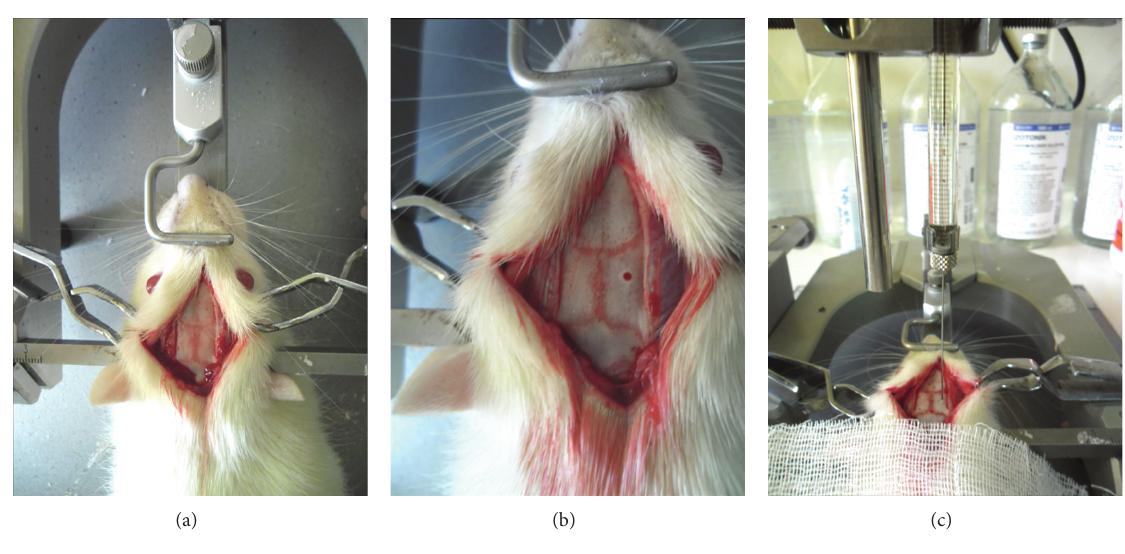
Figure 1: Stereotaxical infusion protocol was shown in rat.